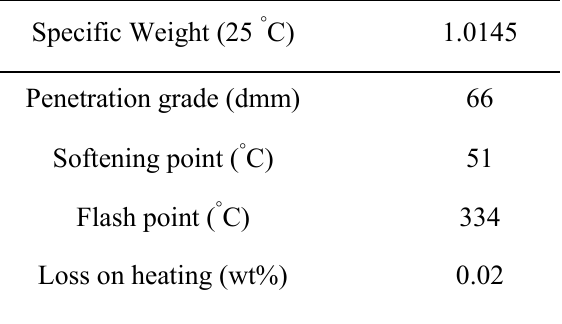
Specification of the bitumen (grade number 60/70) supplied by Jey Oil Com.